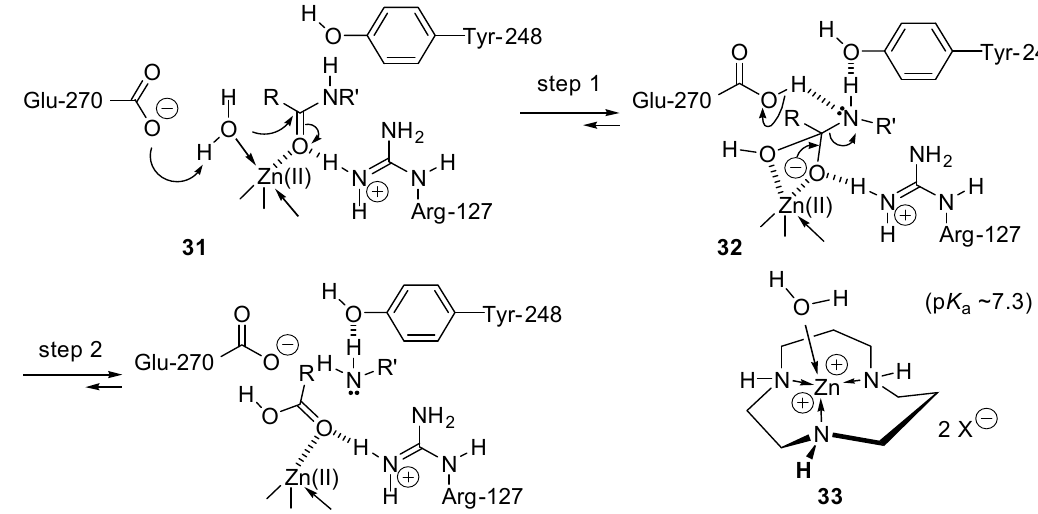
Scheme 17. Carbopeptidase A (prototypical metalloprotease) catalyzed peptide bond cleavage.